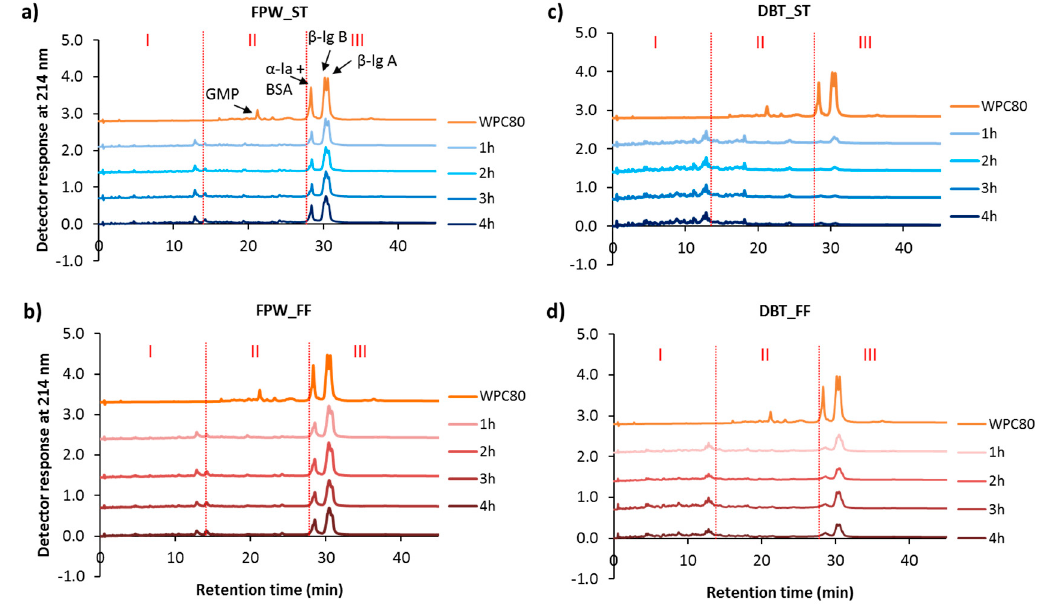
Figure 4. Reverse-phase ultra-performance liquid chromatographic (RP-UPLC) profiles of unhydrolysed whey protein concentrate (WPC80) and the whey protein hydrolysates (WPHs) generated using ( a ) FlavorPro Whey under pH controlled (FPW_ST), ( b ) FlavorPro Whey under non pH controlled (FPW_FF), ( c ) Debitrase under pH controlled (DBT_ST) and ( d ) Debitrase under non pH controlled (DBT_FF) conditions during the course of 4 h hydrolysis. Regions labelled I, II and III represent linear acetonitrile gradients between 0–20%, 20%–40% and >40%, respectively. β -lg: β - lactoglobulin; α -la: α -lactalbumin; BSA: bovine serum albumin; GMP: glycomacropeptide.